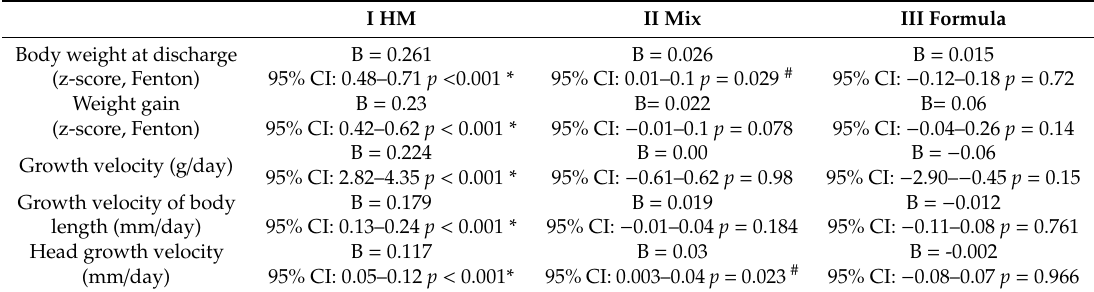
Table 2. E ff ect of probiotics on growth parameters of the GNN cohort during their primary stay in hospital. I HM II Mix III